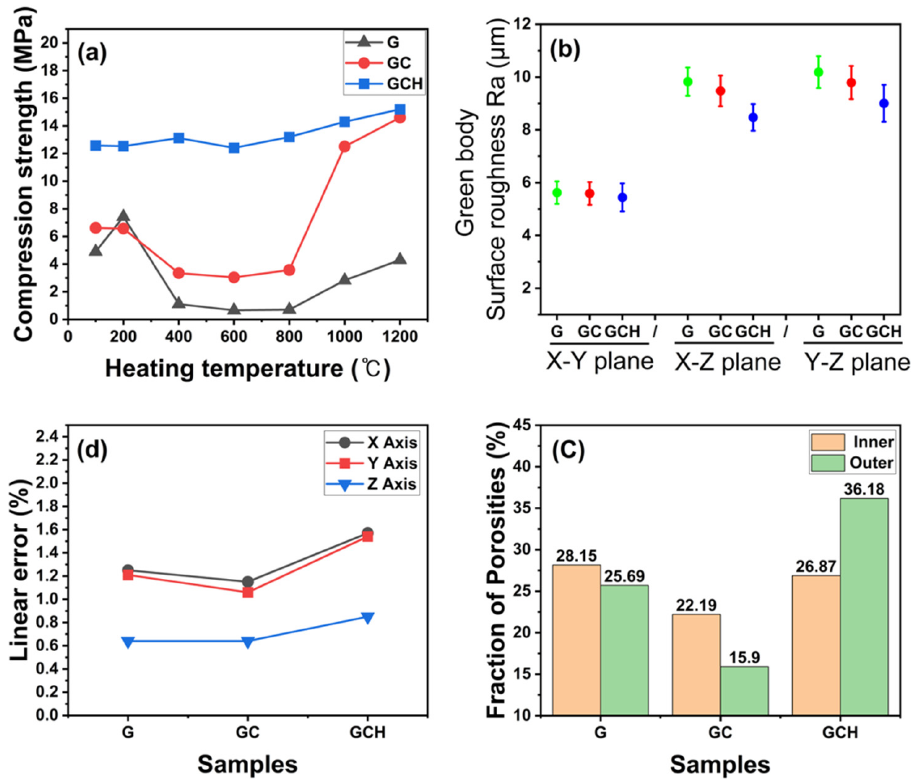
Figure 3. ( a ) Uniaxial compressive strength according to heat treatment temperature ( b ) Ra ( µ m) of XY, XZ, YZ surfaces of the molded body by process ( c ) average porosity inside and outside the molded body (%) ( d ) dimensional error of molded object x , y , z axis.